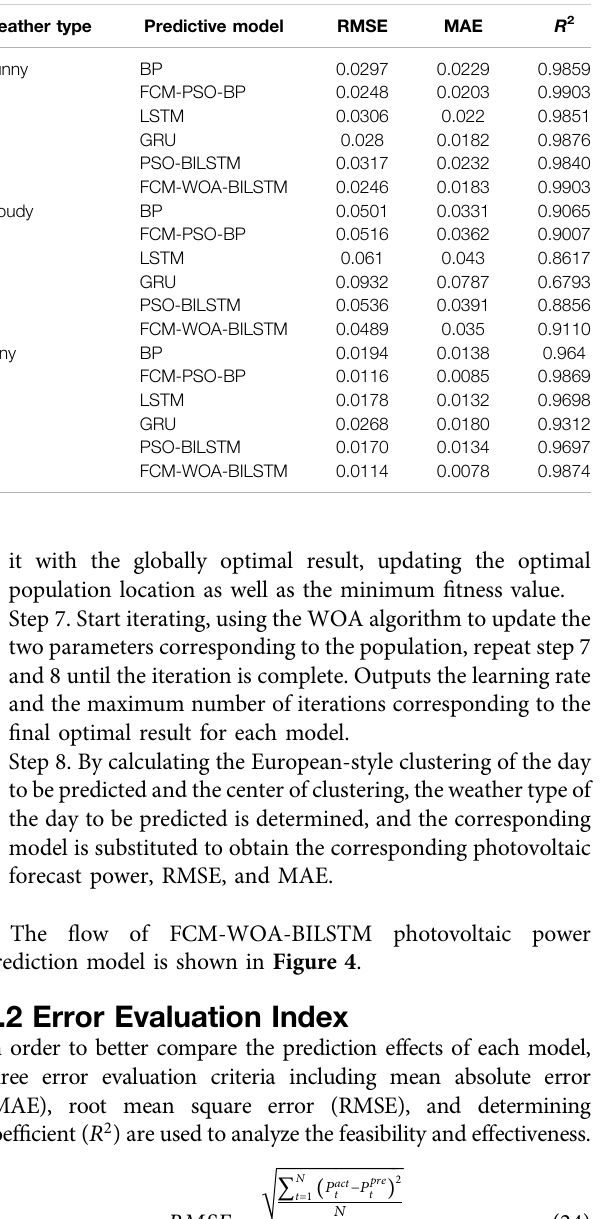
TABLE 2 | Error index of four models. TABLE 3 | Reference values of the evaluation level.